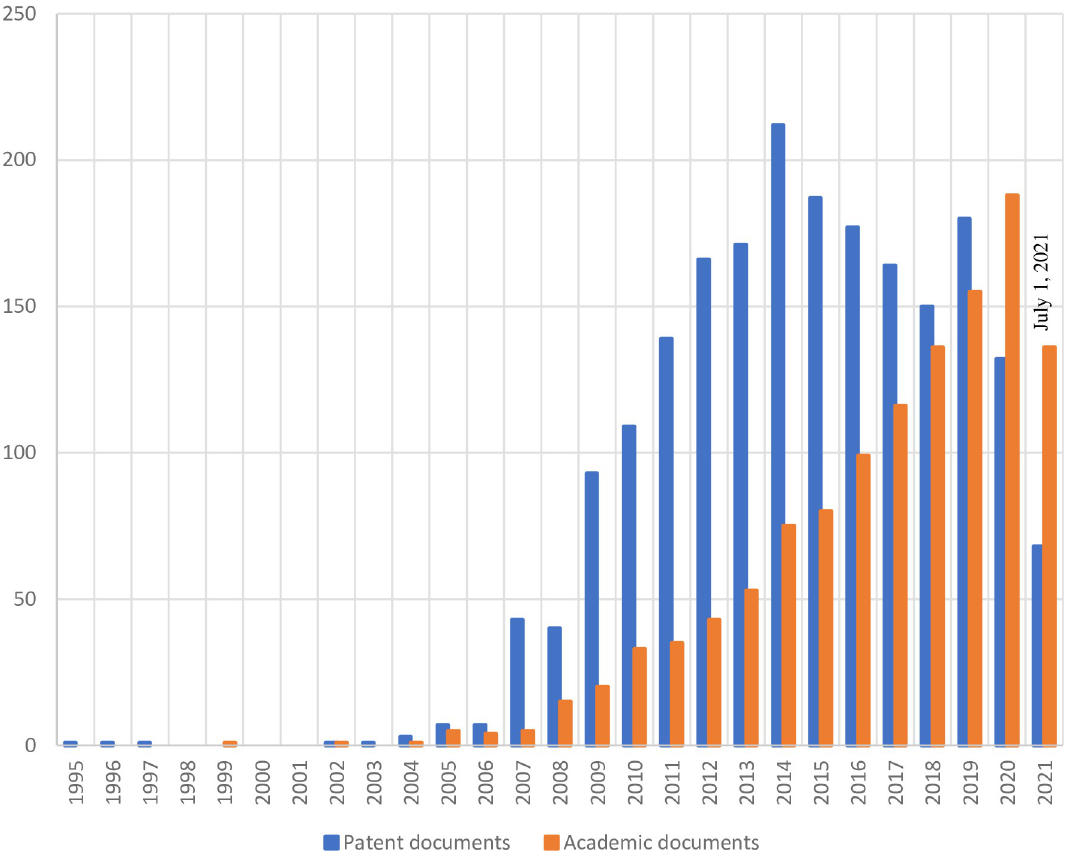
Fig 2. Academic and patent documents. Source: Prepared by the authors based on WIPO [28] & Scopus [29].